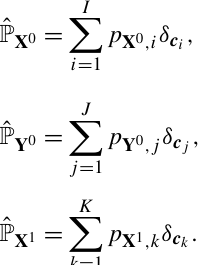
Figure 2. Estimation of the unobserved random variable Y 1 . The random variables X 0 , X 1 and Y 0 are known. Plans γ and ϕ are the optimal joint laws in the sense of Eqs. (2)–(4). e ϕ is the evolution of Y 0 estimated from γ and ϕ . OTC is used to correct X 1 with respect to the estimation of Y 1